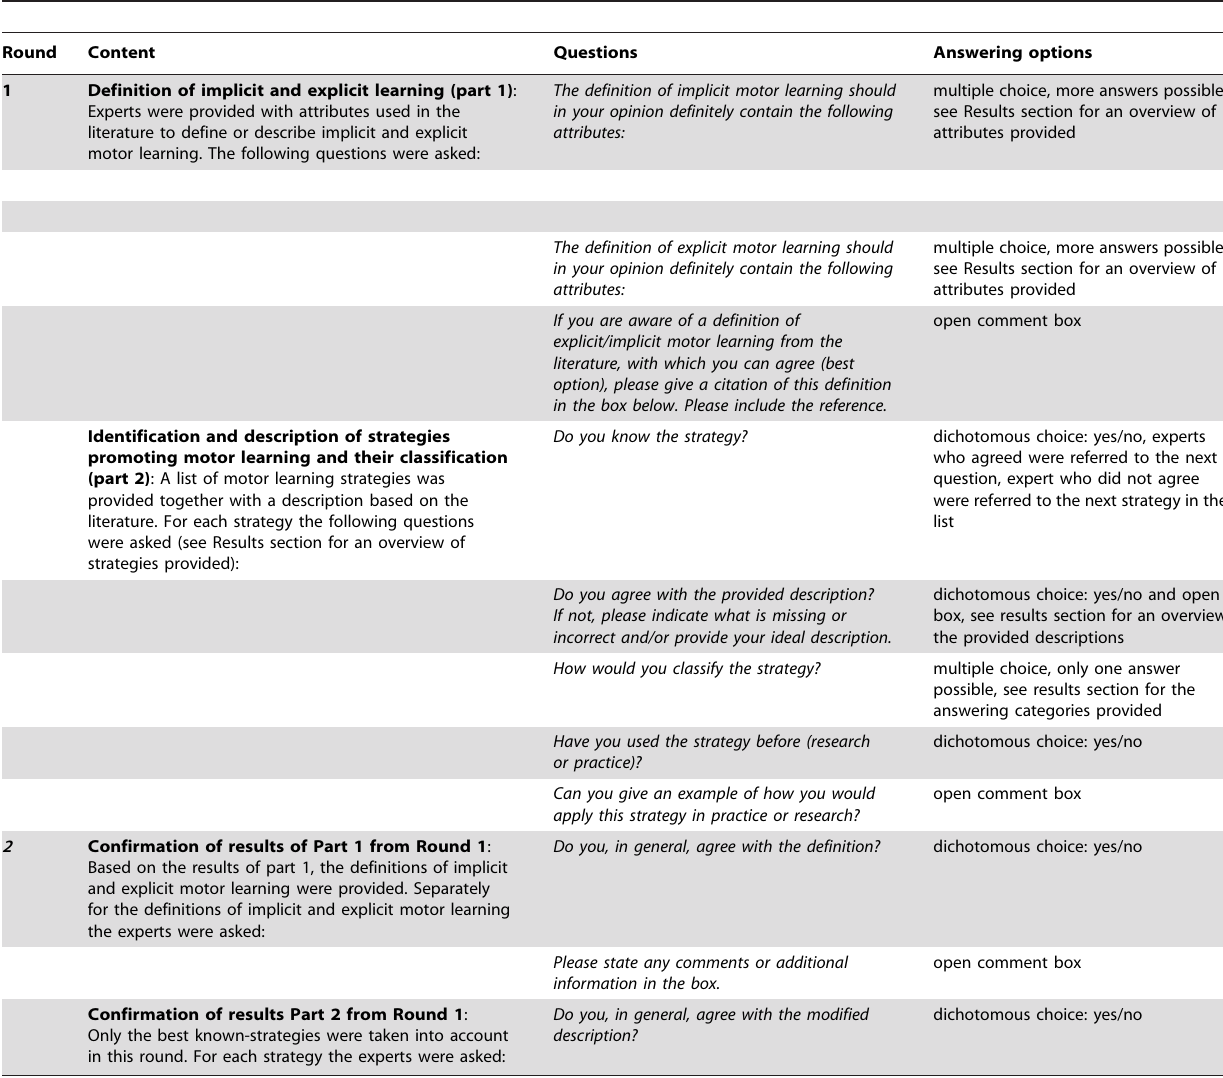
Table 1. Content and structure of the survey rounds.